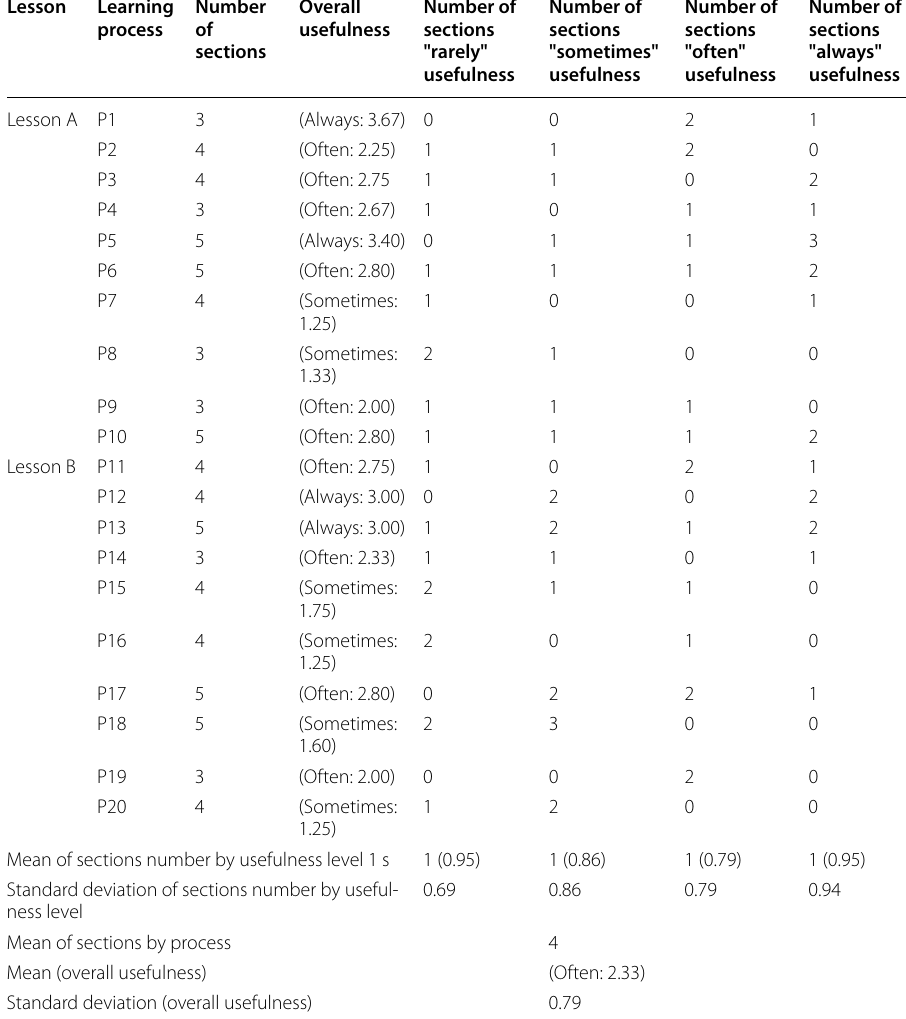
Table 1 Usefulness of learning processes